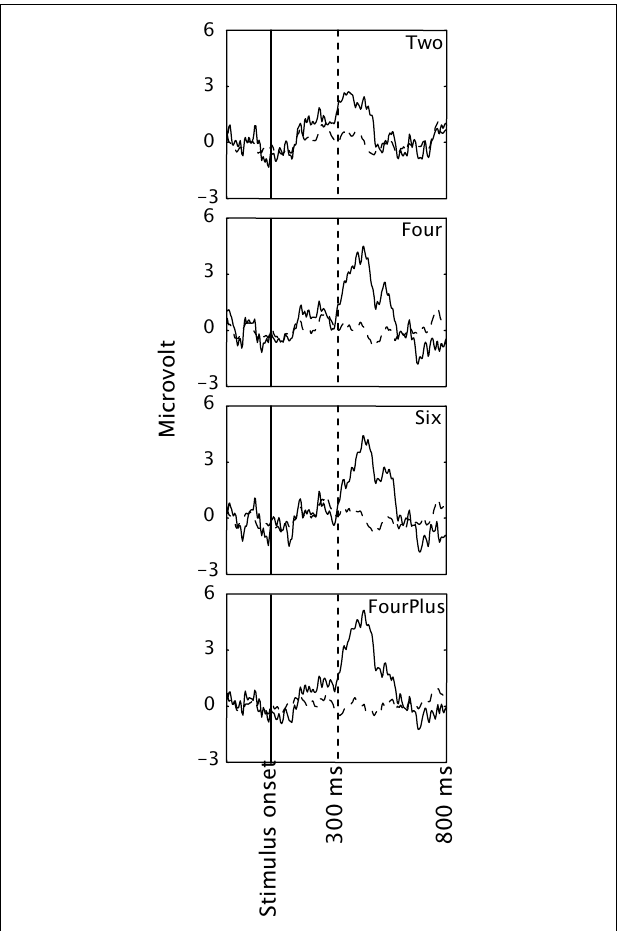
FIGURE 3 | EEG averaged across participants and presented separately for targets (solid lines) and distracters (dashed lines) in the four conditions of Experiment 1. Only data from electrode Pz is